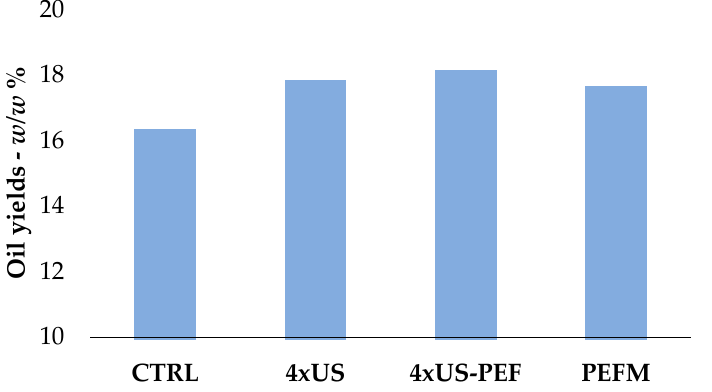
Figure 4. Oil yields obtained from half-ripe Coratina olives using different extraction techniques.